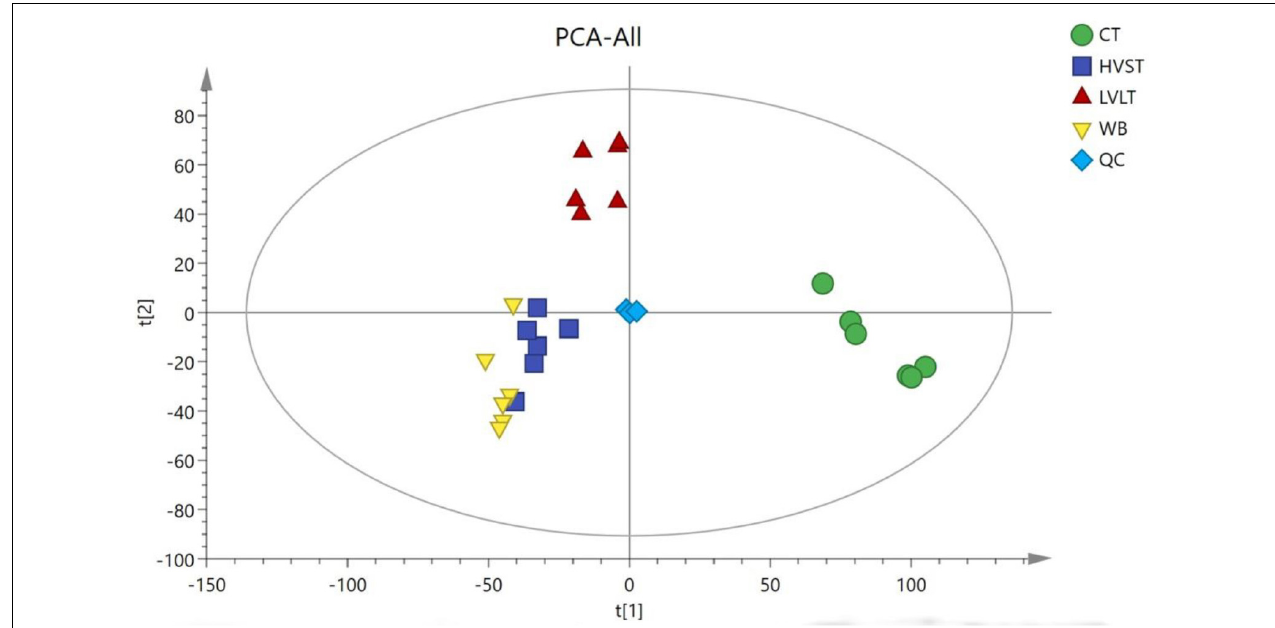
FIGURE 1 | Principal component analysis (PCA) of metabolites from CT, HVST, LVLT, and WB-treated E. coli O157:H7 cells. t[1] was the first principal component, and t[2] was the second principal